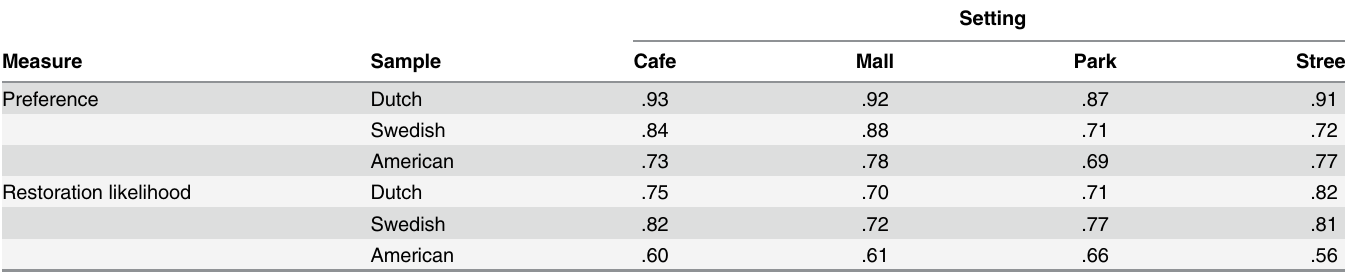
Table 1. Internal consistency coefficients (Cronbach ’ s alphas) for the measures of preference for the different urban settings and judged likeli- hood of restoration in each setting, broken out by the country of the sample. Setting Measure Sample Cafe Mall Park Street Preference Dutch .93 .92 .87 .91 .84 .88 .71 .72 .73 .78 .69 .77 Restoration likelihood .75 .70 .71 .82 .82 .72 .77 .81 .60 .61 .66